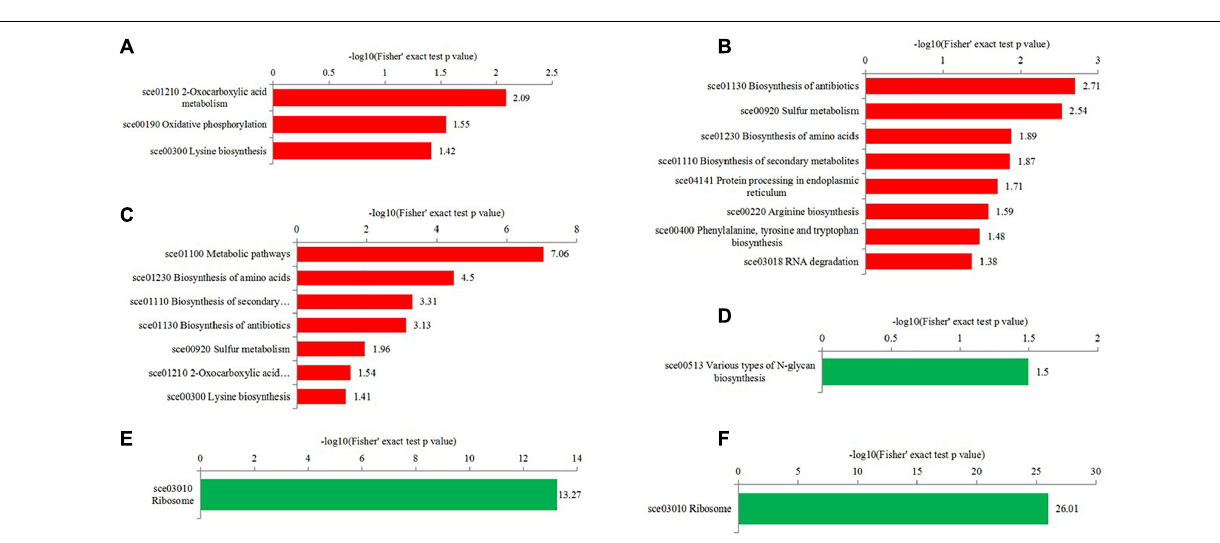
FIGURE 6 | KEGG enrichment analysis of differentially expressed proteins in the different comparisons. (A–C) were upregulated categories in T50/T30, T55/T50, and T55/T30, respectively. (D–F) were downregulated categories in T50/T30, T55/T50, and T55/T30,